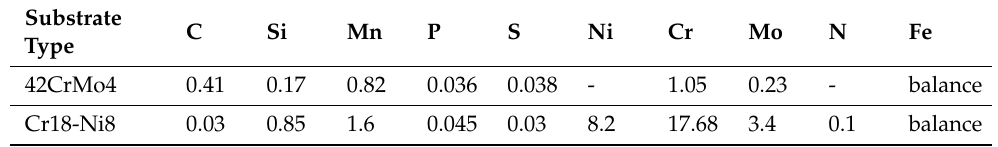
Table 2. Chemical composition (wt.%) of the substrates used for additive